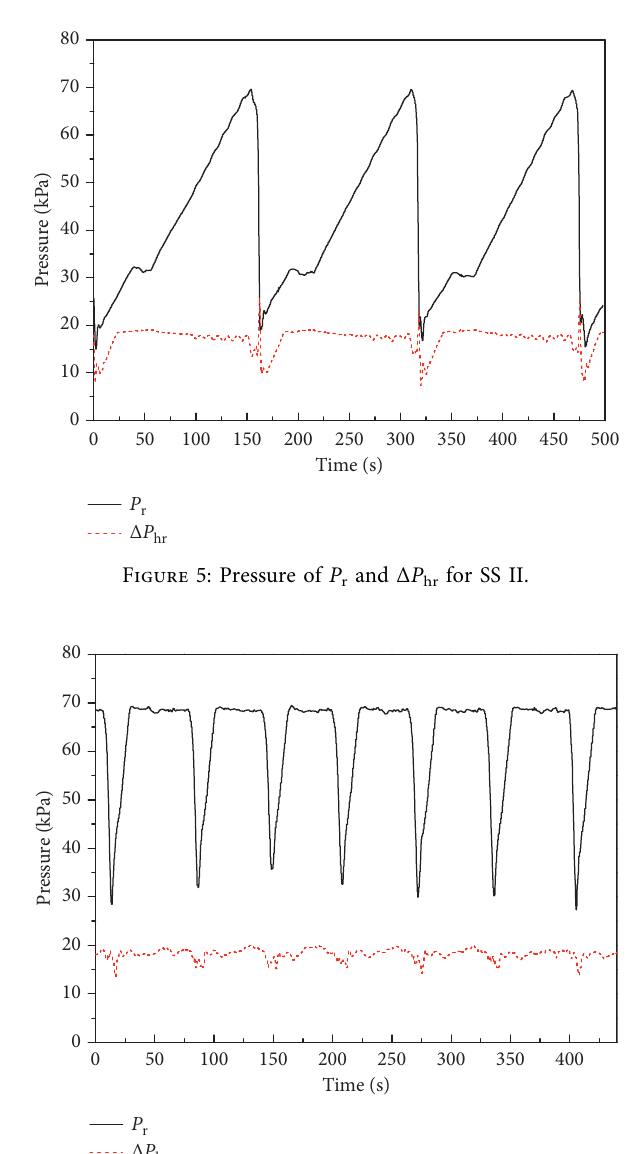
r and Δ P hr for SS